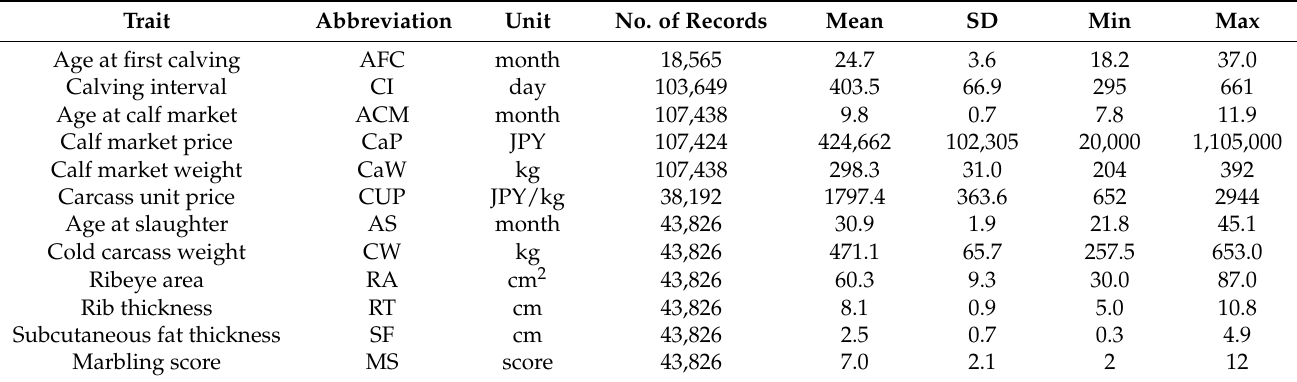
Table 1. Descriptive statistics of traits studied 1 .